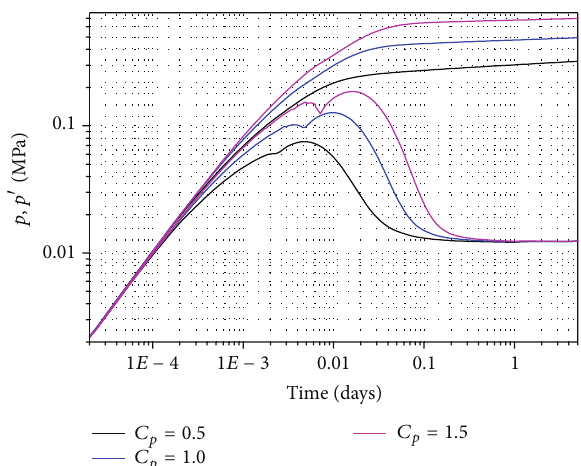
Figure 6: Log-log plot of the well bottom pressure and pressure derivative of the pressure fall-off period for different 𝑀 - 𝑉 curves with the same injection polymer concentration of 0.7 kg/m 3 .